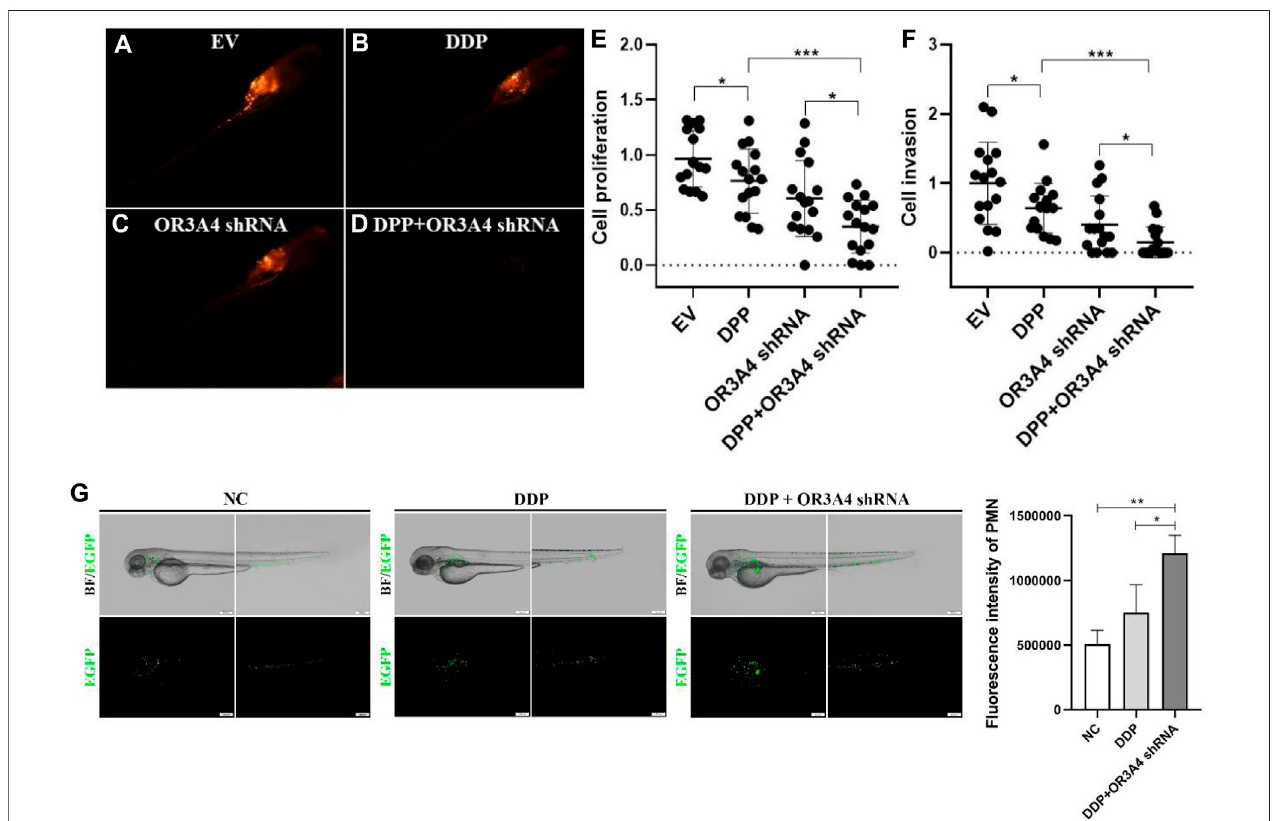
FIGURE 6 | Concurrent treatment with DDP and knockdown of OR3A4 enhanced the tumor inhibition of cisplatin in the zebra fi sh xenografts model (A – D) The representative imaging of zebra fi sh larvae treated with DDP, knockout OR3A4, and concurrent treatment (E – F) Statistical effects of DPP, knockdown of OR3A4, and concurrent treatment on the proliferation and migration of SKOV3 cells in a zebra fi sh xenograft model (G) The representative images of the effects on the migration and aggregation of neutrophils in zebra fi sh larvae treated with DDP and knocked out OR3A4. *p < 0.05 , ***p < 0.001 , n (cid:2) 16.